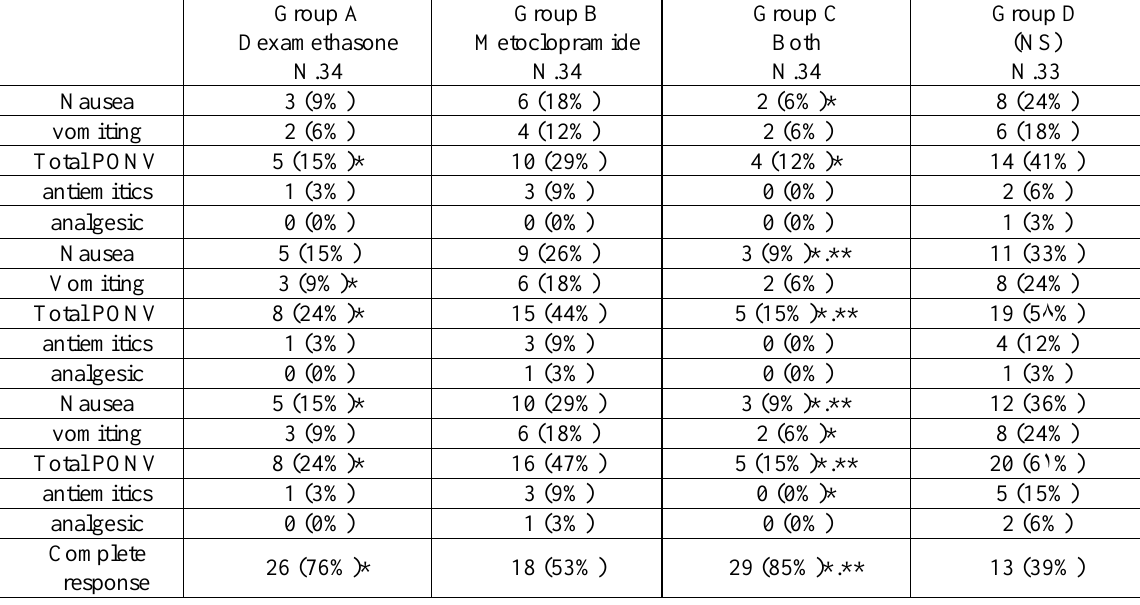
Table 2: Incidence of nausea and vomiting during 24 h postoperatively according to medication